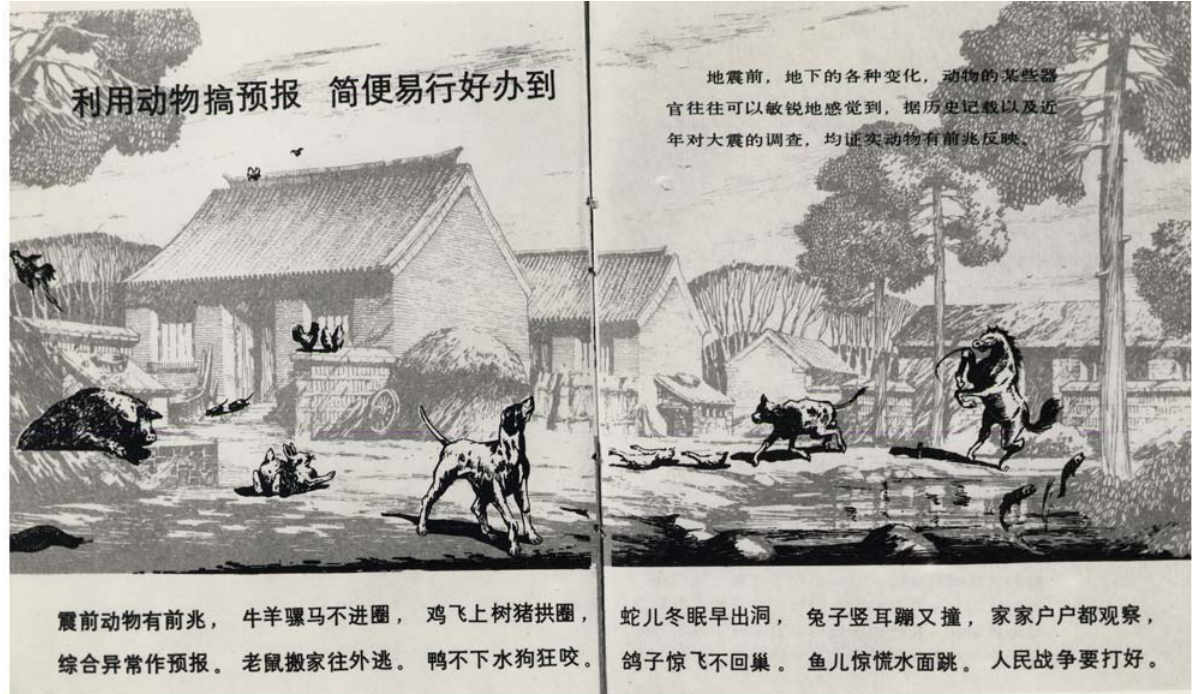
Figure 3. Chinese flyer, distributed to country people with the intention of explaining the behaviour of animals prior to earthquakes, which should be